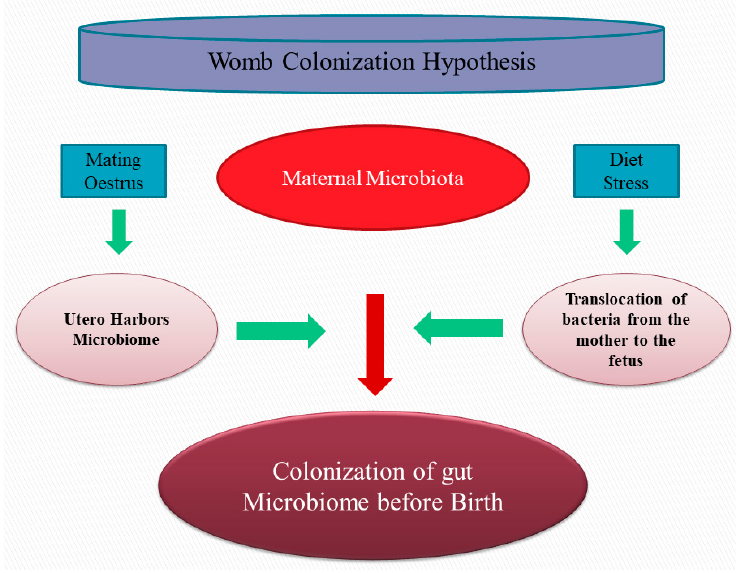
Figure 2. During pregnancy, the intestine of fetus is colonized by micro-organisms of the